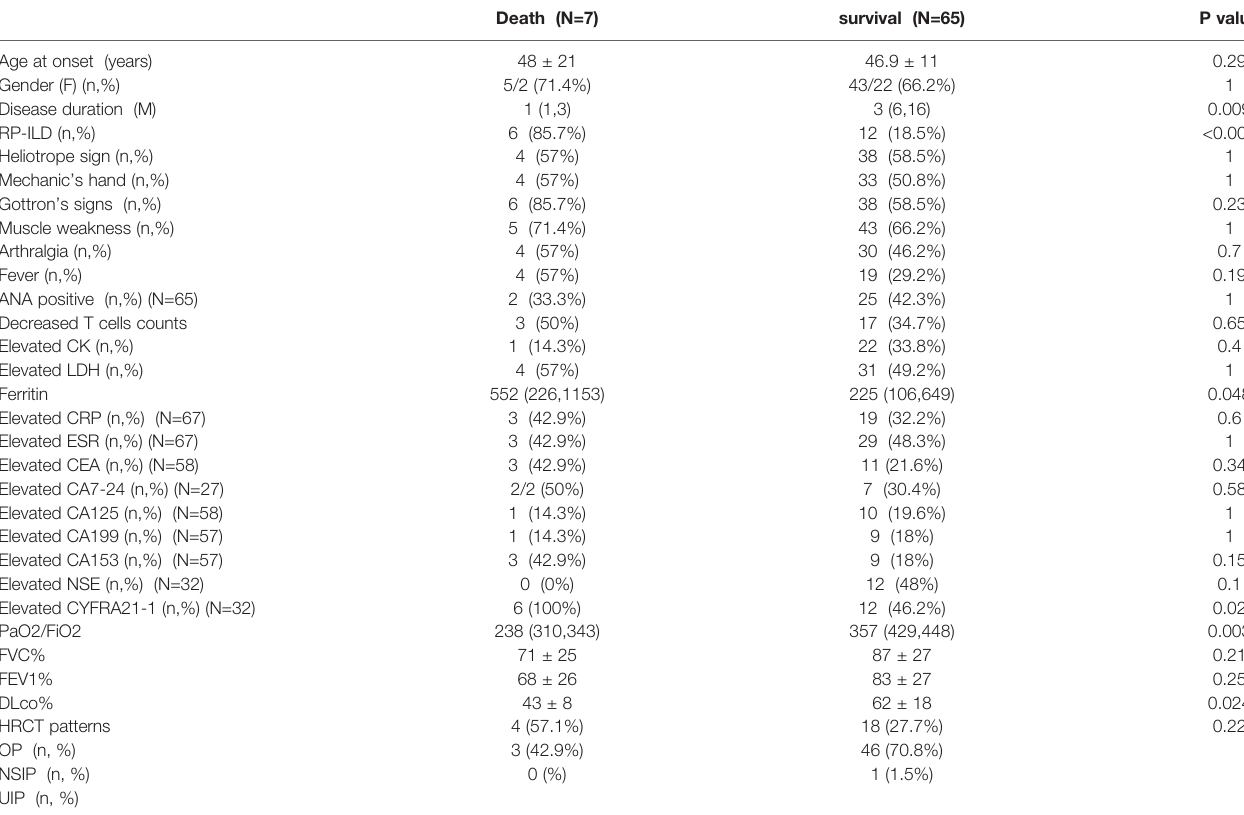
(Table 4 Breakdown): Continuous data were presented as M (mean) ± SEM (standard error of the mean), or medians (interquartile range). Binary data were presented as n (%) of the patients; RPILD, rapidly progressive interstitiallung disease; CK, creatine kinase; LDH, Lactate Dehydrogenase; CRP, c reactive protein;ESR, erythrocyte sedimentationrate; FVC,Forced Vital Capacity; FEV1, Forced Expiratory Volume In 1s; DLco, diffusing capacity for carbon monoxide; UIP, usual interstitial pneumonia; NSIP, nonspeci fi c interstitial pneumonia; OP, organizing pneumonia.